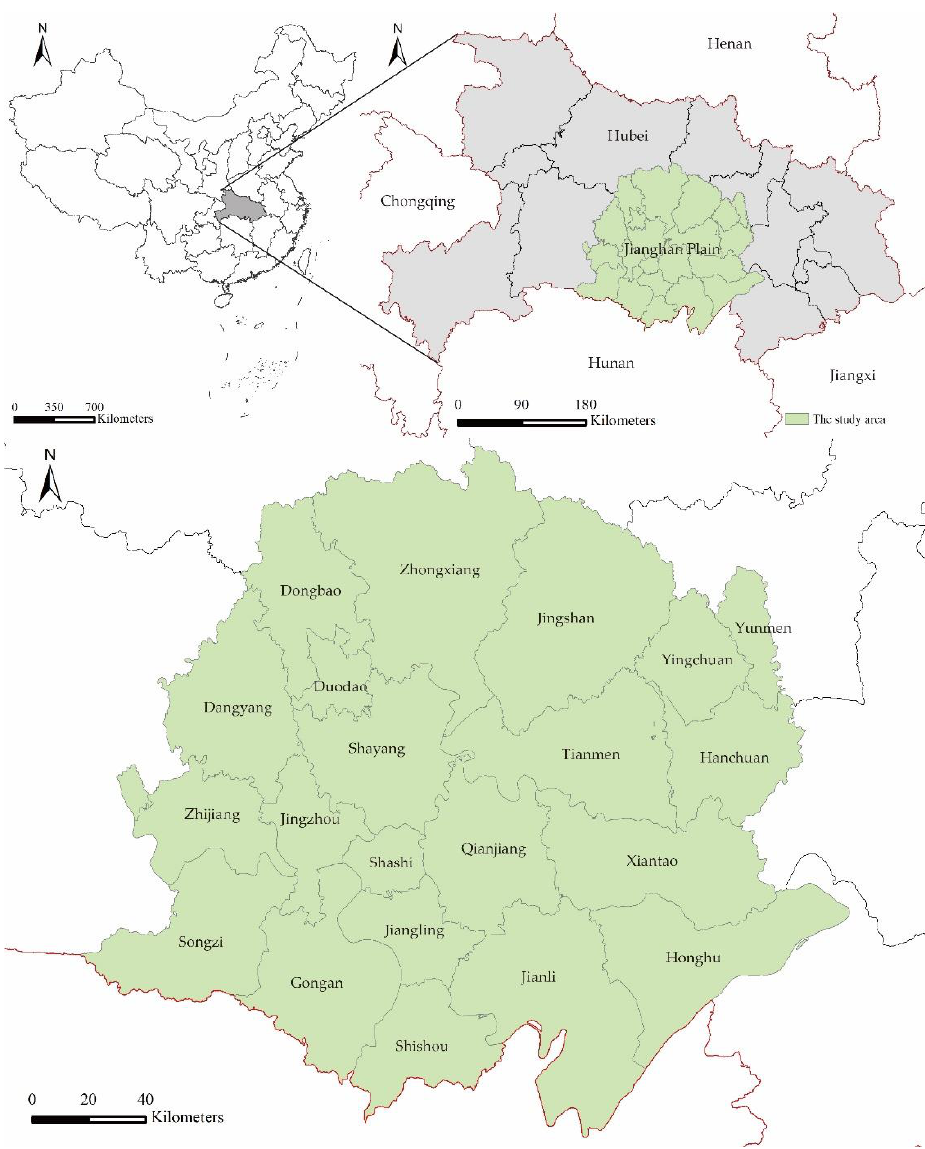
Figure 2. Location of the study